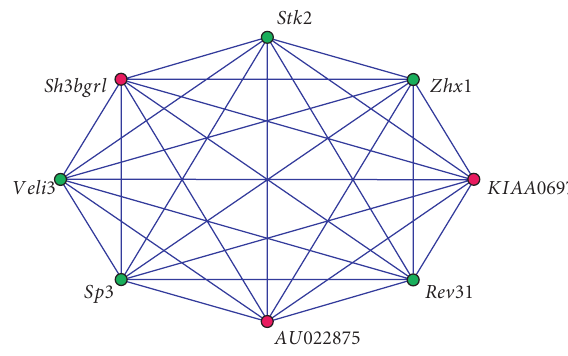
Figure 6. A relevant clique containing Veli3